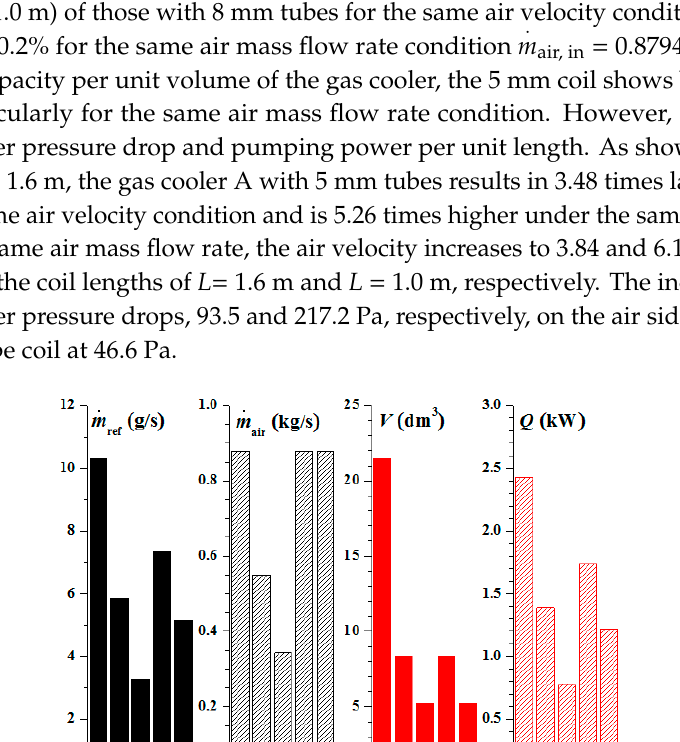
Figure 14. Comparison between 8 mm and 5 mm coils gas cooler A for m (cid:4662) ref , m (cid:4662) air , V, and Q .